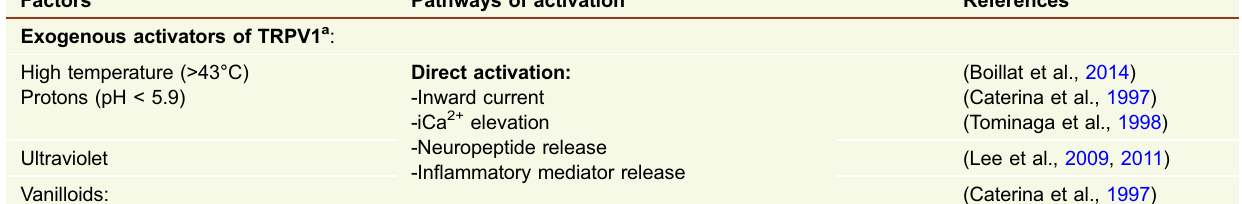
Table 1. Endogenous and exogenous agonists involved in TRPV1 activation, sensitization, and inhibition